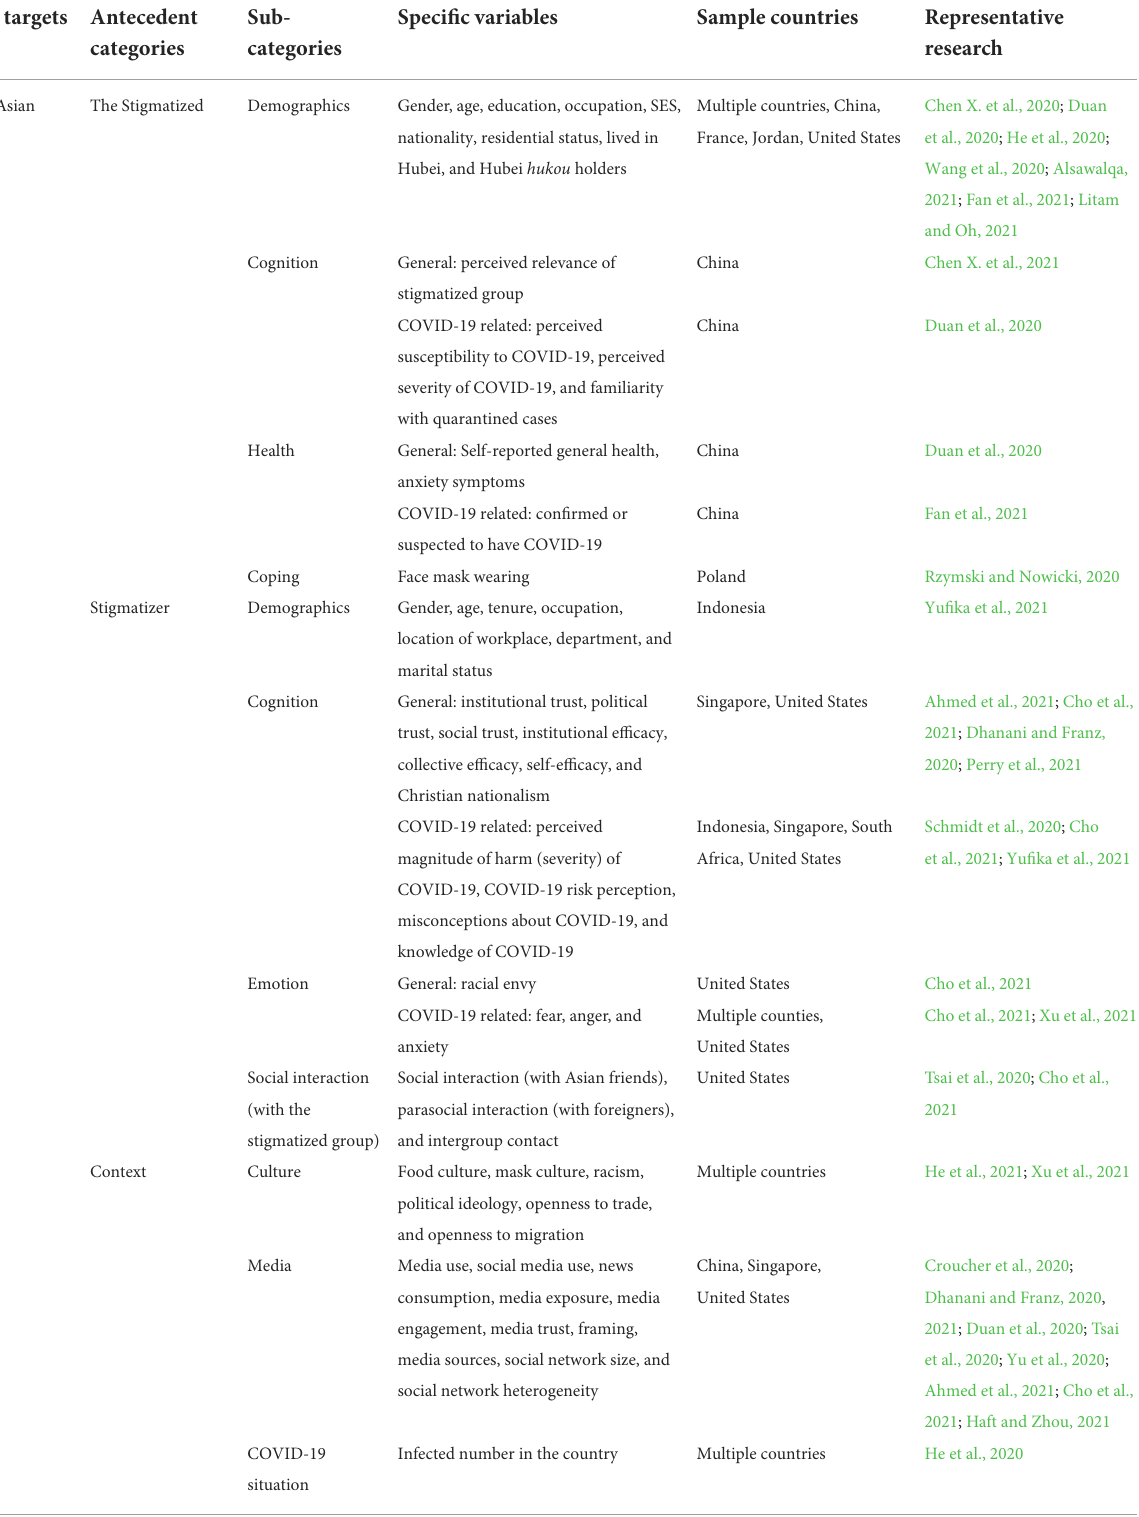
TABLE 1 Antecedents for stigma